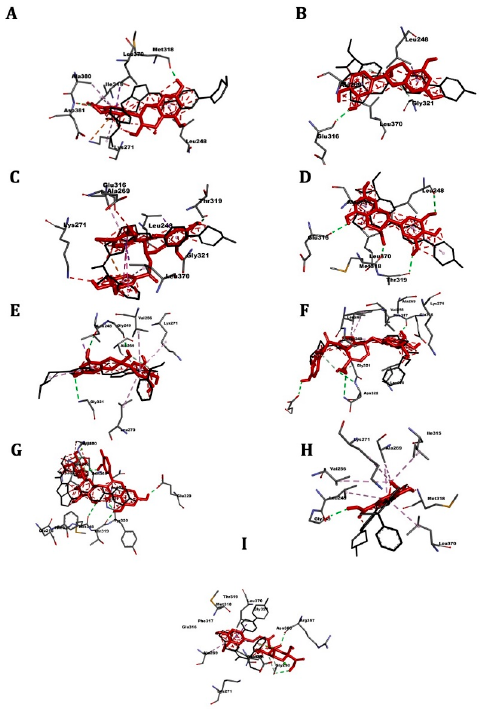
Figure 6. 3D scheme of the ligand–ABL1 receptor interactions. In red, tested molecule ( A ) catechin, ( B ) epicatechin, ( C ) epicatechin gallate, ( D ) epigallocatechin, ( E ) gallocatechin, ( F ) oleuropein, ( G ) rutin, ( H ) vanillic acid, ( I ) chlorogenic acid; in black, reference molecule (danusertib) and labeled